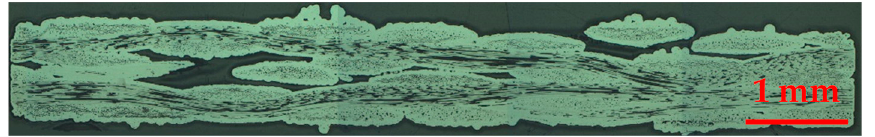
Figure 2. SiC/SiC sample section capture by optical microscopy. Table 2. SiC/SiC specimen characteristics. () standard deviation.